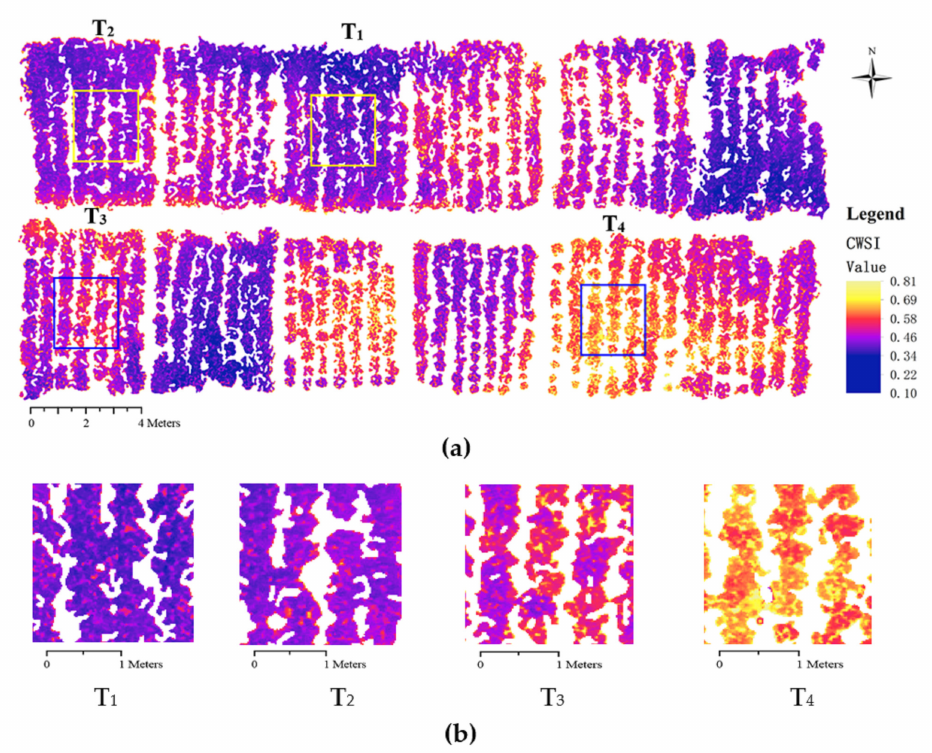
Figure 8. ( a ) Map of simplified CWSI measured at 13:00; ( b ) Map of CWSIsi for specific regions in the T 1 , T 2 , T 3 , and T 4